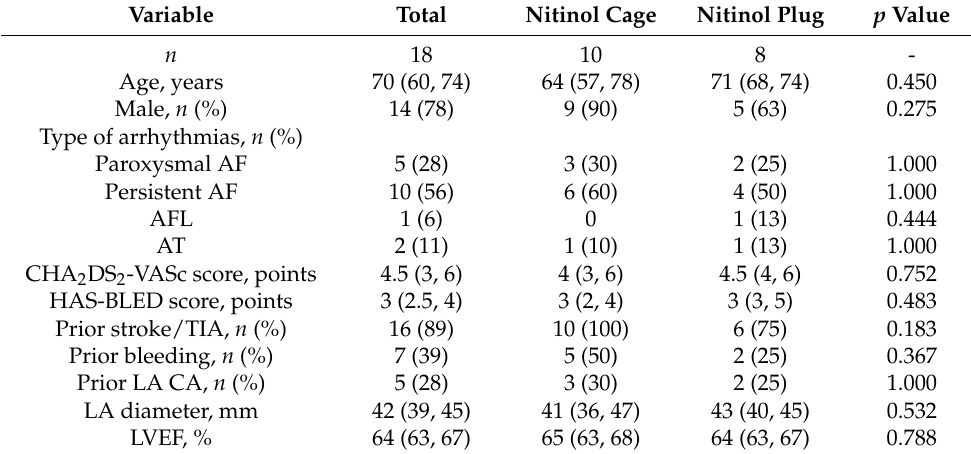
Table 1. Baseline